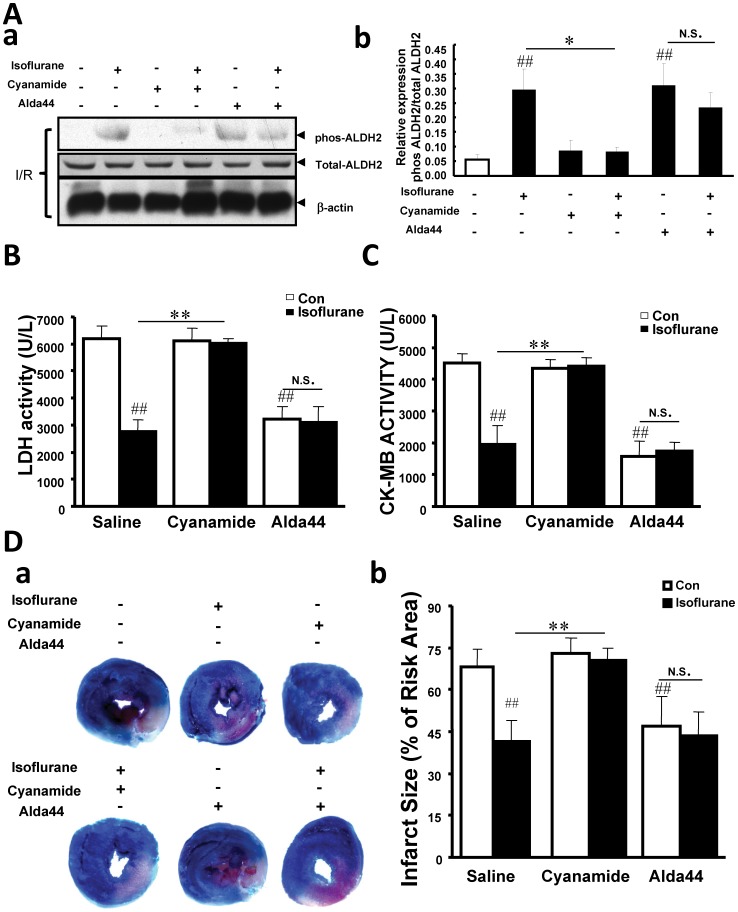
Phosphorylation of ALDH2 associated with isoflurane-induced cardioprotection.A. Effects of isoflurane preconditioning with and without the ALDH2 inhibitor (cyanamide), and direct activator of ALDH2 (Alda-44) on phosphorylation of ALDH2. (a) Representative of western blot analysis of the phosphorylation of ALDH2 (phos-ALDH2 top lanes) and total ALDH2 (middle lanes). β-actin (lower lanes) was used to demonstrate equal protein loading. (b) Quantification of phos-ALDH2 to the total ALDH2 from 3 independent experiments. B, C. Serum LDH and CK-MB concentrations were analyzed. D. The effects of ALDH inhibitor (cyanamide), and direct activator of ALDH2 (Alda-44) on infarct area in rat hearts. (a) Representative cross-sectional slices derived from a single heart. (b) The infarct size normalized to the area at risk. Values are means ± S.E.M., n = 8 in each group. ##P<0.01 vs. the saline control group and *P<0.05, **P<0.01 vs. the corresponding control.